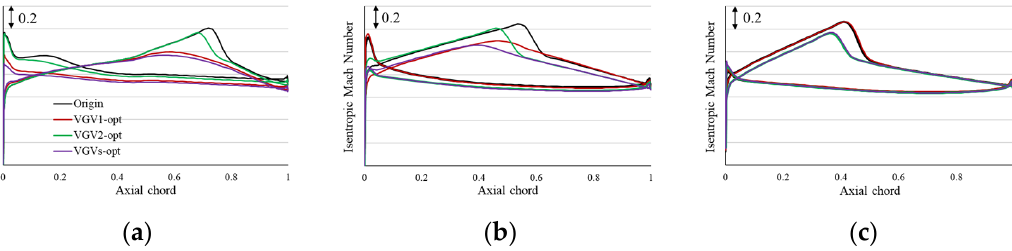
Figure 24. Incidence spanwise distribution (VGV joint adjustment). ( a ) R1; ( b ) R2; ( c ) R3; ( d ) S1; ( e ) S2.